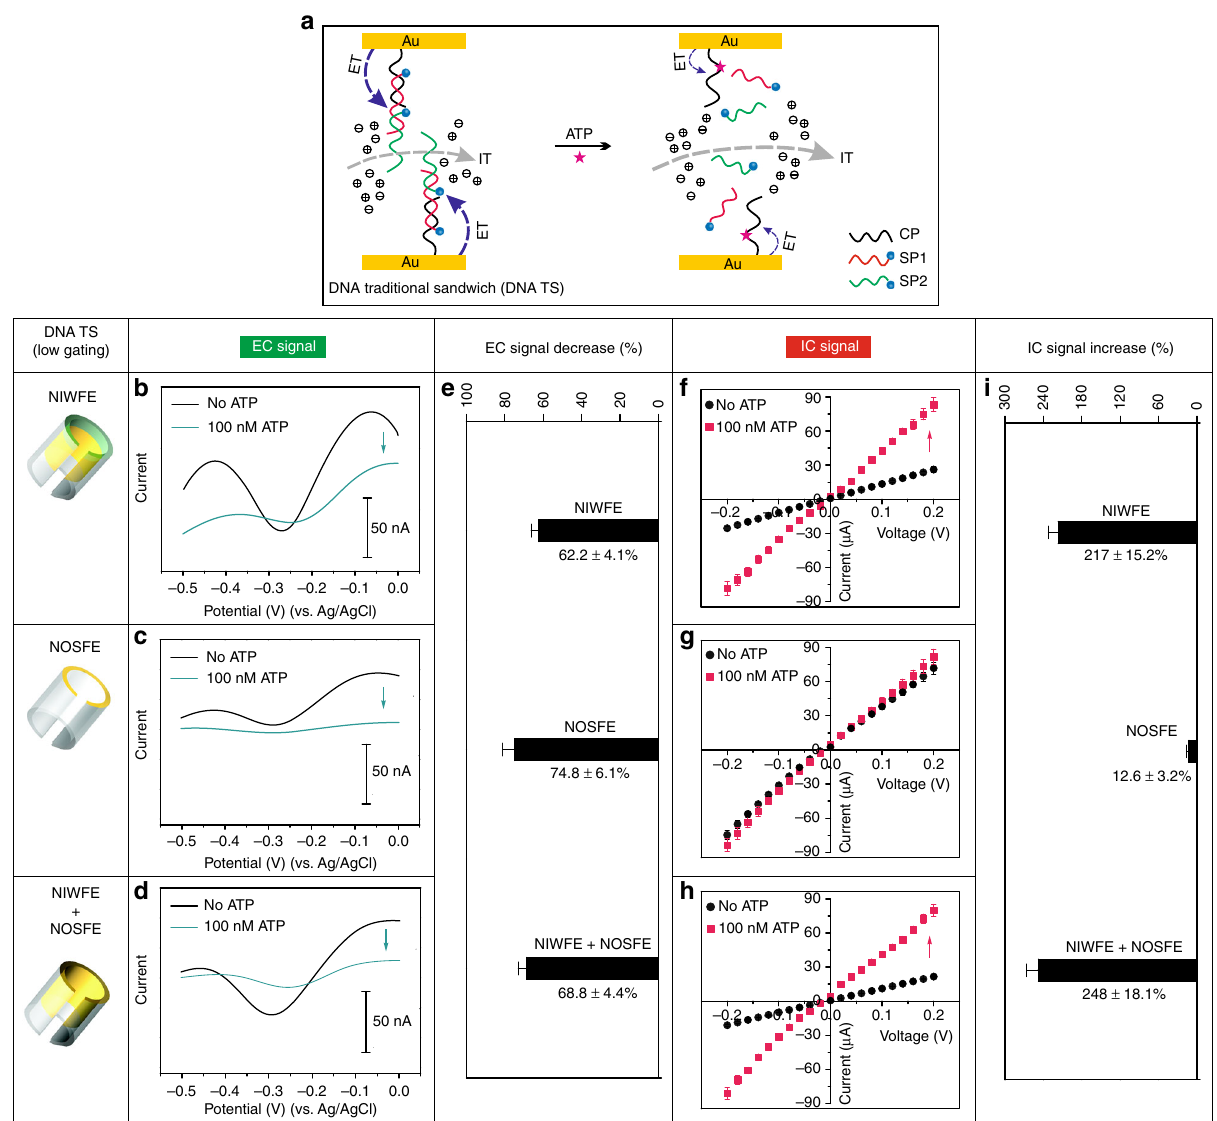
Fig. 2 Low-ef fi ciency ion-gating systems probed by dual-current readout. a Schematic of IT (dashed gray arrow) and ET (dashed blue arrow) through double labeling, ATP-responsive, DNA TS-based biomimetic nanochannels. Shown here is the disassembly process at the inner of nanochannels. b – d SWV curves of the assembled DNA TS and the disassembly by ATP at different regions of AAO nanochannels. e Comparison of EC signals change at the DNA TS-based ATP recognition events. f – h I – V traces of the assembled DNA TS and the disassembly by ATP at different regions of AAO nanochannels. i Comparison of IC signals change at the DNA TS-based ATP recognition events. Error bars represent standard deviations of independent triple